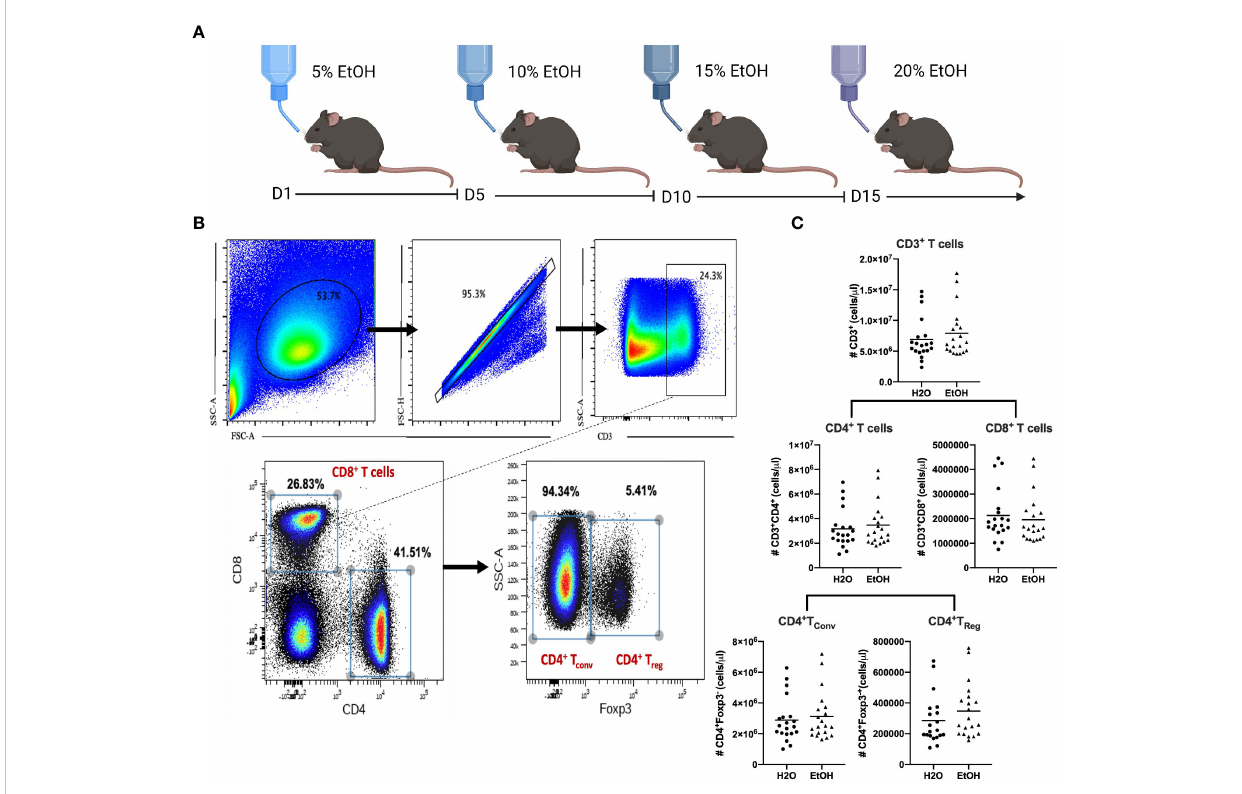
FIGURE 1 Chronic alcohol exposure does not impact absolute numbers of CD4 + or CD8 + T cells. (A) , Mice (n=20/group) were subjected to 12-weeks of an alcohol or water diet as described in Materials and Methods followed by sacri fi ce and collection of splenocytes for fl ow cytometry. (B) , Gating strategy to identify conventional CD4 + and CD8 + T cells as well as Foxp3 + Treg. (C) , The number of CD3 + T cells, CD8 + T cells, CD4 + T cells, CD4 + T conv or CD4 + T Reg did not differ between water- vs . alcohol-exposed mice. Data were tested for normality and compared with either t test or Mann-Whitney